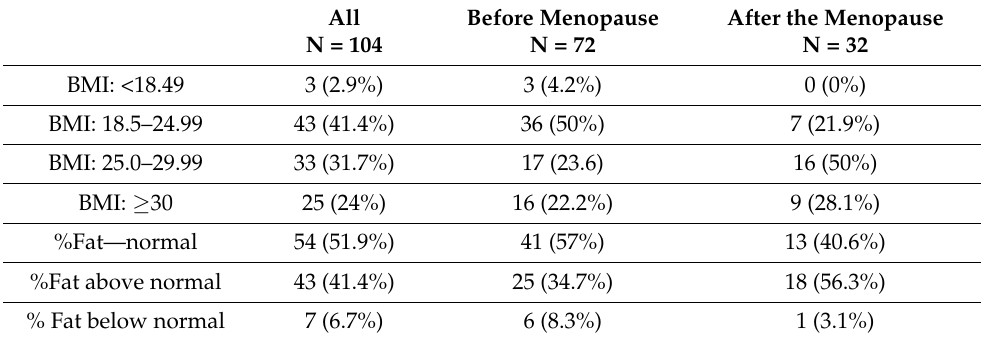
Table 2. Distribution of BMI and percentage body fat in the study group of patients. All